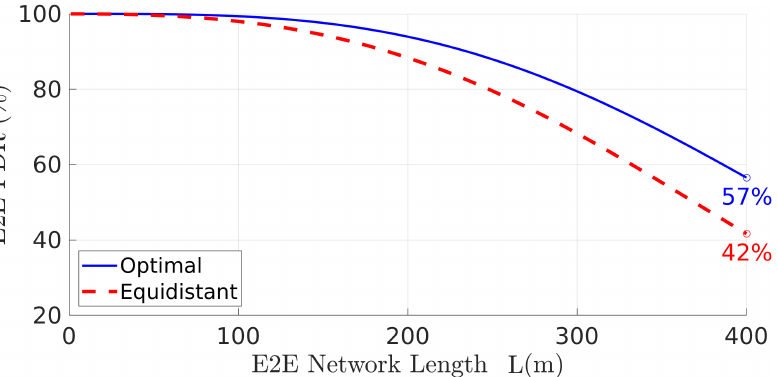
Figure 9. PDR P net improves significantly when the optimal placement is used instead of equidistant positions, especially for larger network lengths.